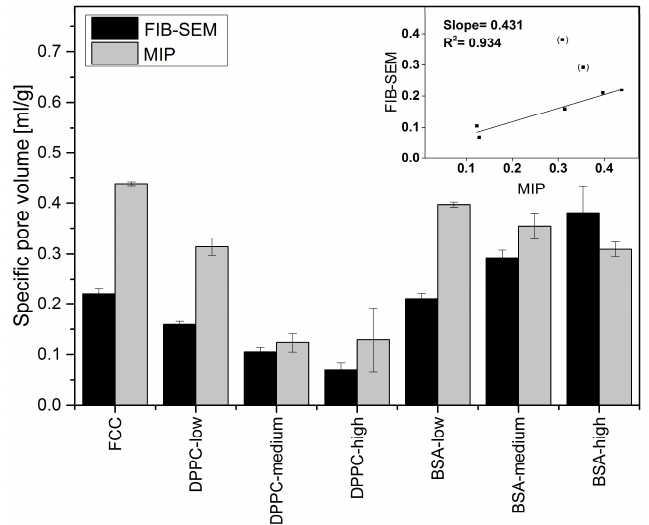
Figure 7. Specific pore volumes of FCC formulations. Pore volumes were calculated based on FIB-SEM image analysis (black) or by MIP (grey). Insert: correlation plot for both methods. Values are means ± SD, ( n ≥ 3).